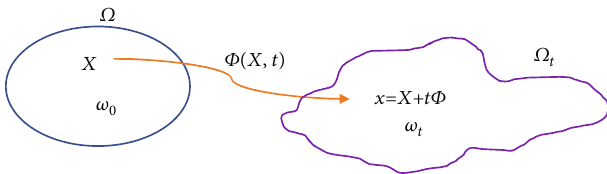
Figure 3: Mapping from the Langrangian coordinate to Eulerian